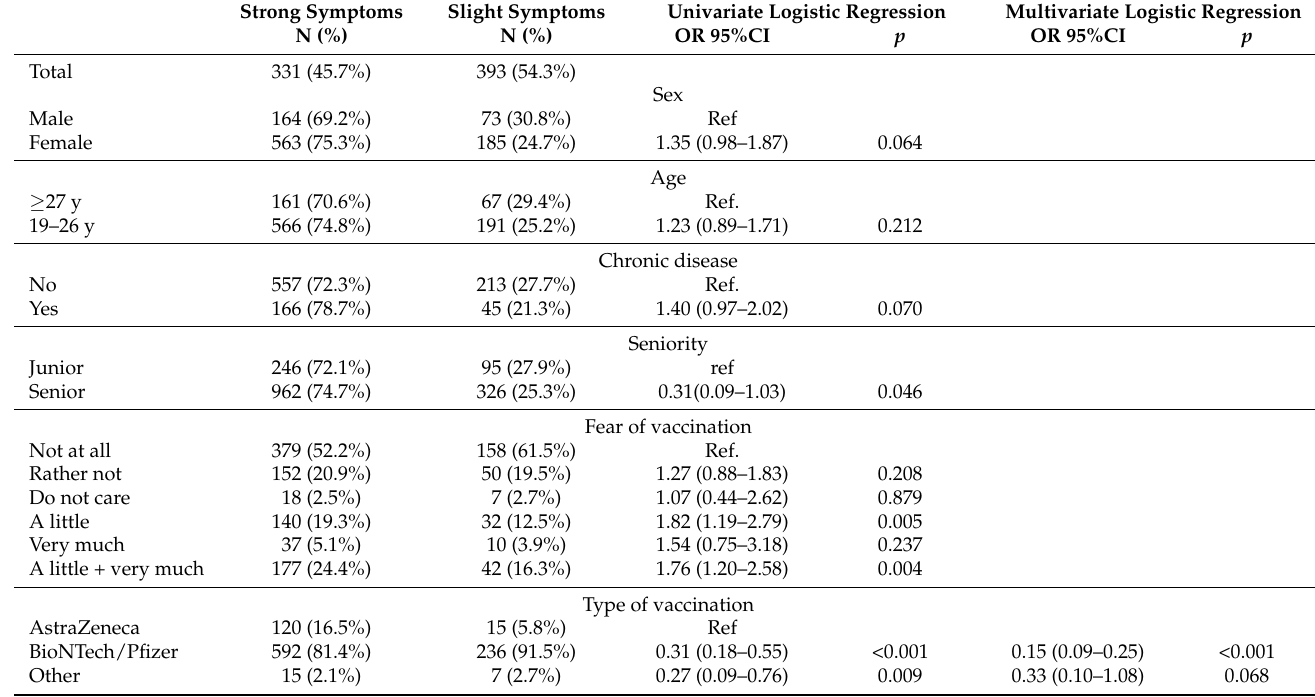
Table 7. Associations between sex, age, chronic disease, seniority, fear of vaccination, the type of vaccine, and the strength of symptoms in adverse reactions after vaccination.